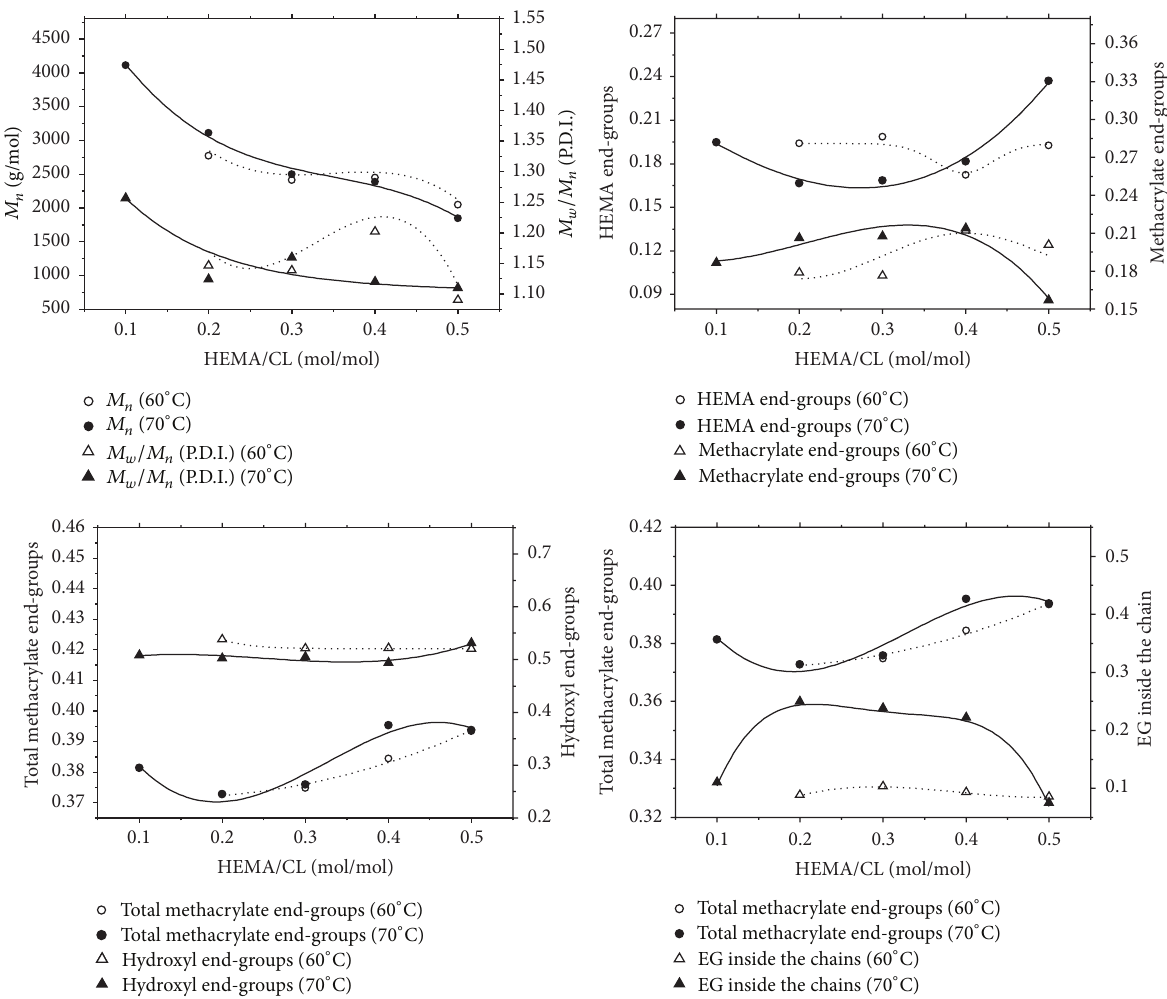
Figure 8: The effect of HEMA/CL, at 60 ∘ C and 70 ∘ C, on 𝑀 𝑛 , polydispersity, HEMA, methacrylate, total methacrylate, hydroxyl end-groups, and EG inside the chains (Synthesis at 60 ∘ C versus 70 ∘ C, 6 hours, and 200 mg/45 mmole Novozyme-435/CL).